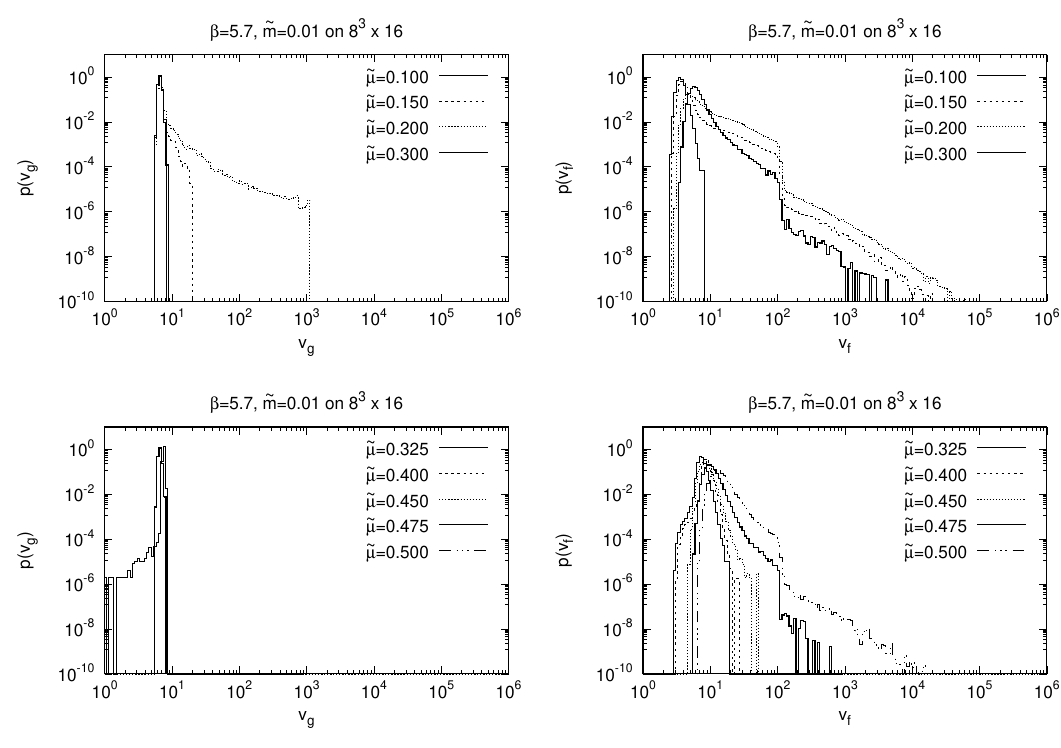
Figure 1 . The probability distributions p ( v ) of the drift term obtained from simulations on a 8 3 (cid:2) 16 lattice with (cid:12) = 5 : 7 and ~ m = 0 : 01 are plotted for the drift term v g coming from the gauge action (Left) and v f from the fermion determinant (Right). The upper and lower panels show